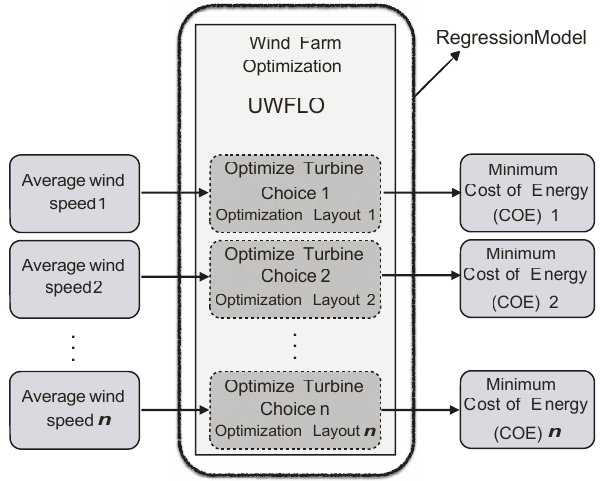
Figure 9. Implementation of a multiplicative regression model to represent the minimum COE (for each class) as a function of